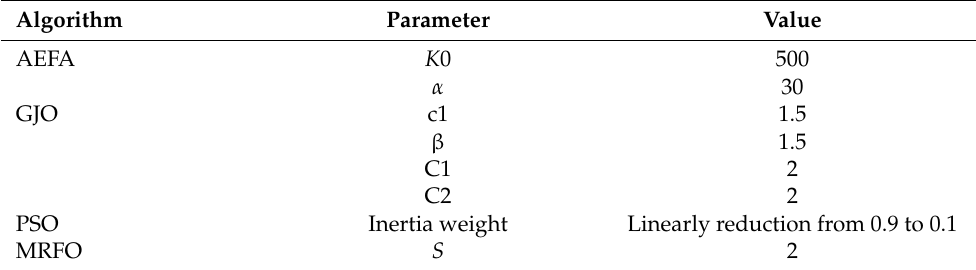
Table 2. Control parameters for different